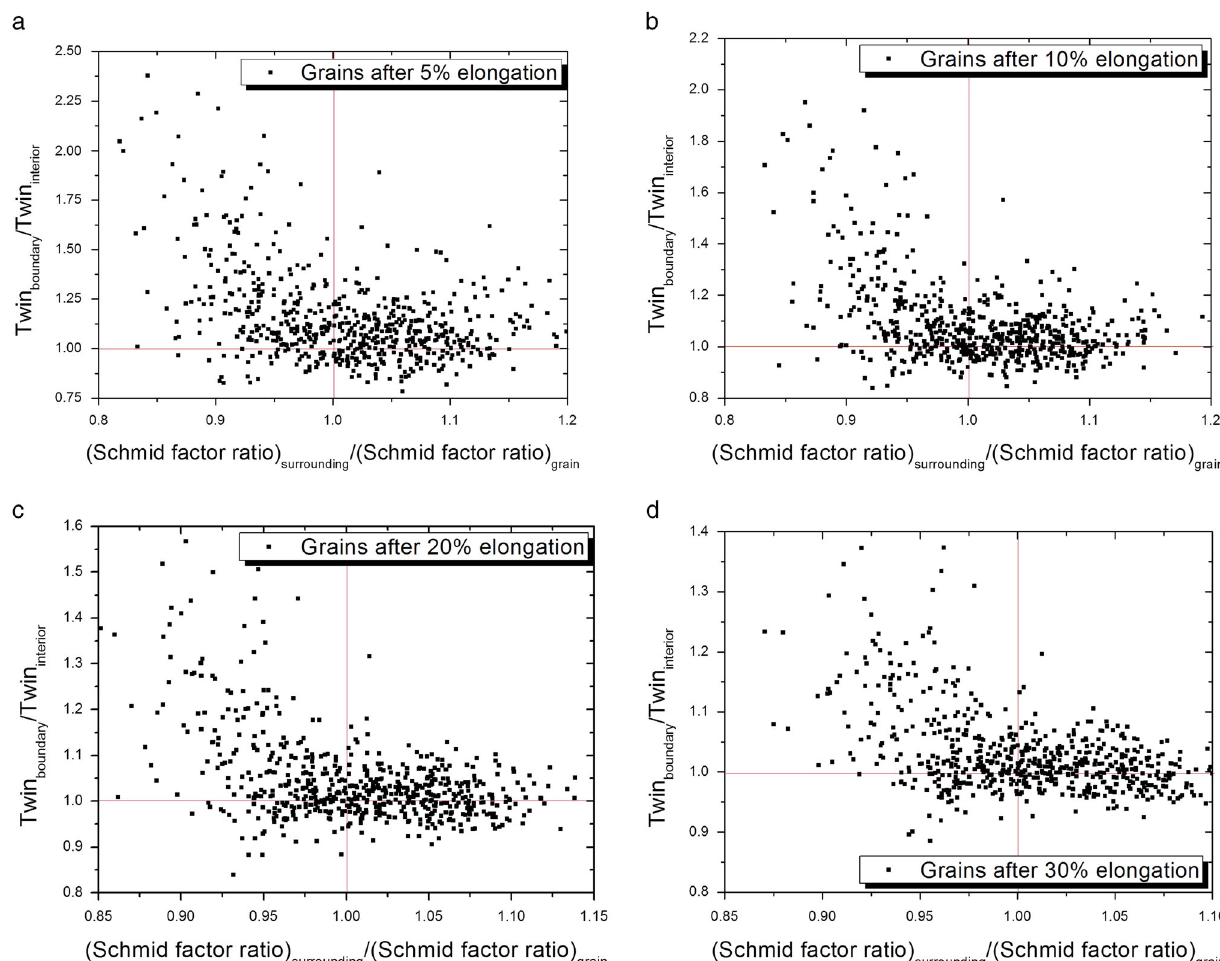
Fig. 7 The ratio between twin volume fraction in grain boundary region to that within interior region of a grain plotted against the ratio between Schmid factor ratio of the grain to that of its surrounding after a 5%, b 10%, c 20%, and d 30% elongations,